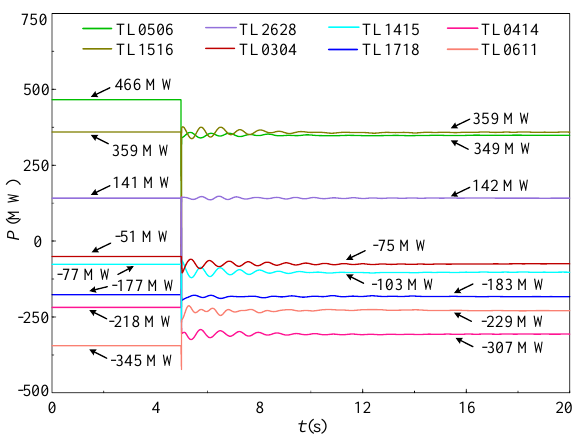
Fig. 7 The active powers on the AC transmission lines.